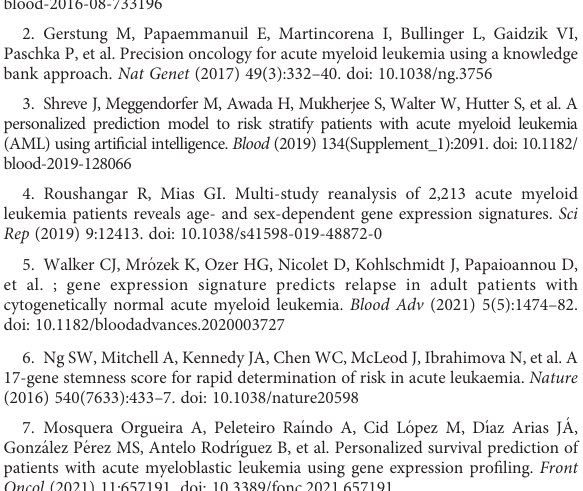
SUPPLEMENTARY TABLE 1 List of 69 genes included in Stellae-123. SUPPLEMENTARY TABLE 2 Distribution of the different driver mutations in the BeatAML cohort according to the risk tertile assigned by Stellae-123. SUPPLEMENTARY TABLE 3 Distribution of the different driver mutations in the AMLCG-8 cohort according to the risk tertile assigned by Stellae-123. SUPPLEMENTARY TABLE 4 Distribution of the different driver mutations in the TARGET AML cohort according to the risk tertile assigned by Stellae-123. SUPPLEMENTARY FIGURE 1 Outcomes of patients strati fi ed according to the ELN-2017 criteria in the BeatAML (A) and AMCLG-2008 (B) cohorts, as we as those of pediatric patients inthe TARGETAMLcohort strati fi ed accordingto theClinical Risk Score (C) . SUPPLEMENTARY FIGURE 2 Outcomes of pediatric patients (TARGET AML dataset) according to tertiles of expected survival predicted by Stellae-123 in the low-risk (A) , intermediate risk (B) and high risk (C) groups de fi ned according to the Clinical Risk